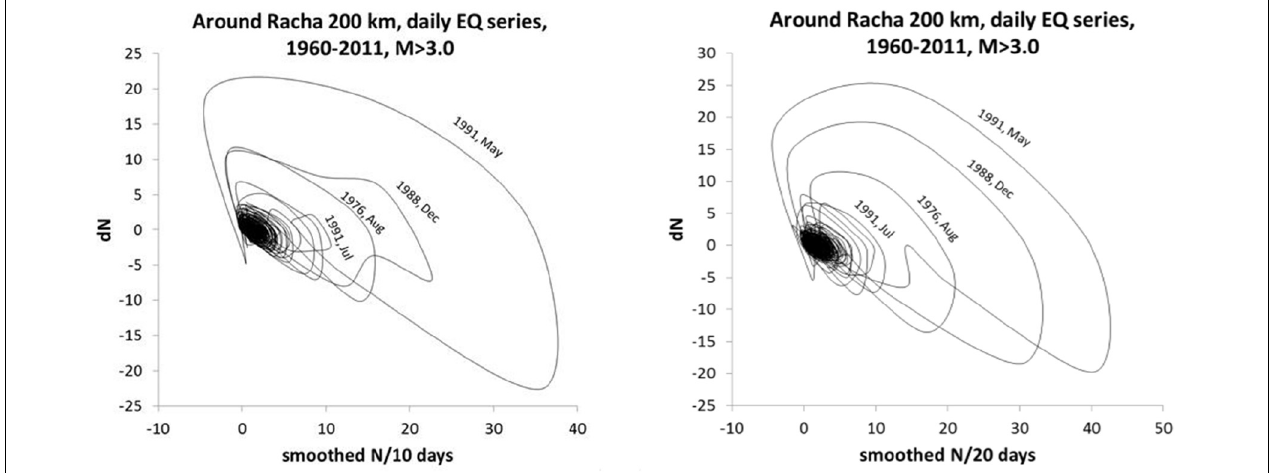
FIGURE 1 | Phase space portraits plotted for the number of EQs N smoothed by the Savitzky–Golay filter versus dN using the declustered catalog (10 and 20 days of smoothed EQ number with a 1-day step) for the area with R = 200 km around the Racha EQ epicenter. On the X -axis are plotted the mean values of the number N of EQs per n days, and on the Y -axis is plotted a differential of N for n days, i.e., ( N i = n - N i ) = dN for n = 10 (left) and 20 (right) days. The dates on trajectories mark strong EQ